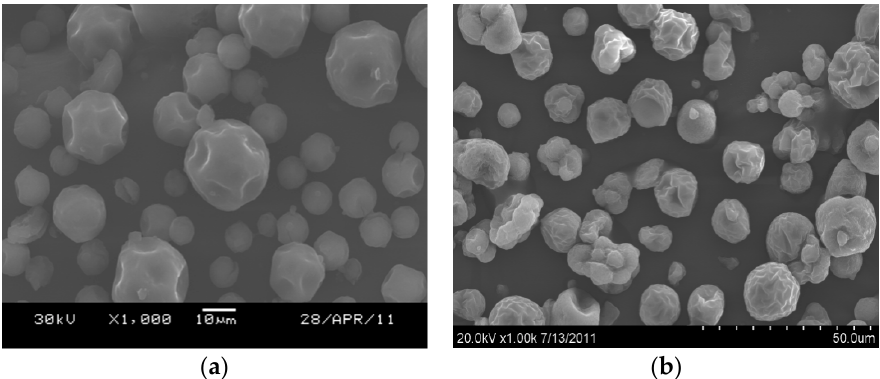
Figure 7. Morphology of the catalyst: ( a ) with n -butyl chloride; ( b ) without n -butyl chloride.